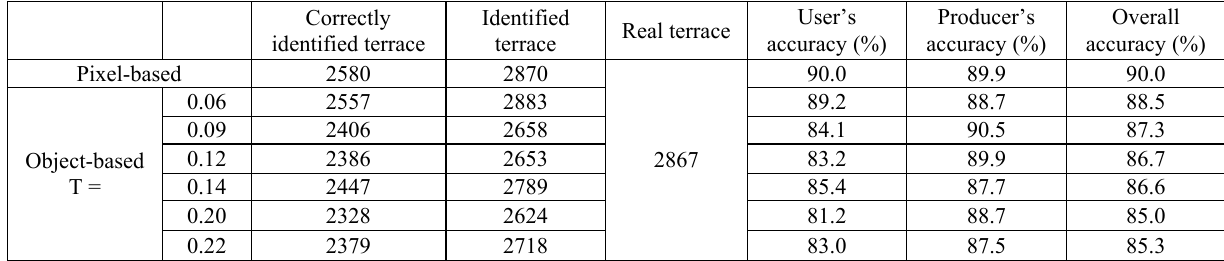
Table 1. Accuracies of terrace classification (unit: sample point)